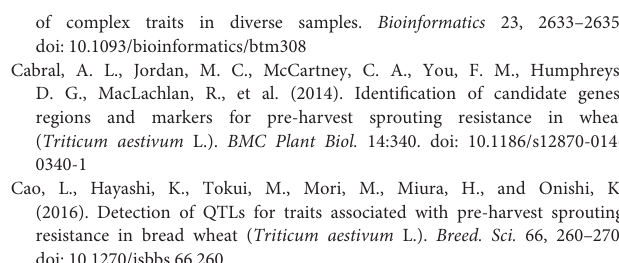
Supplementary Table 7 | Information of reported QTL for PHS on the chromosome 7B. Supplementary Table 8 | Genotypes of Qphs.caas-4AL and Qphs.caas-7BL and GI of 101 wheat cultivars. Supplementary Table 9 | Information of reported QTL for PHS on the chromosome